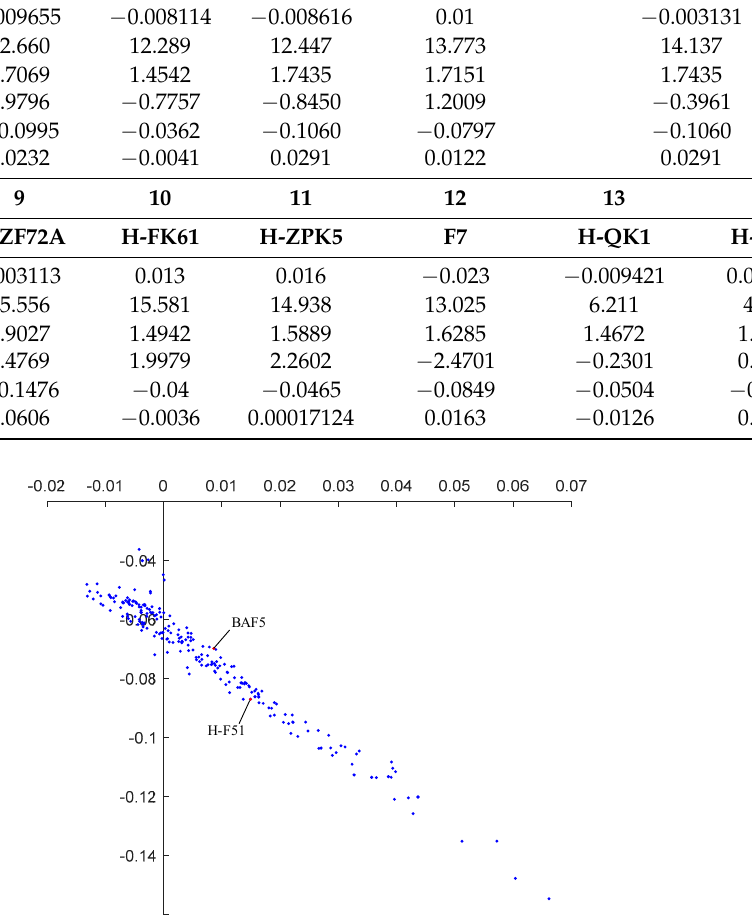
Figure 9. Dispersion coefficient of each lens and the dispersion vector of the initial system. Table 4. Ray-tracing parameters of the optimized system.